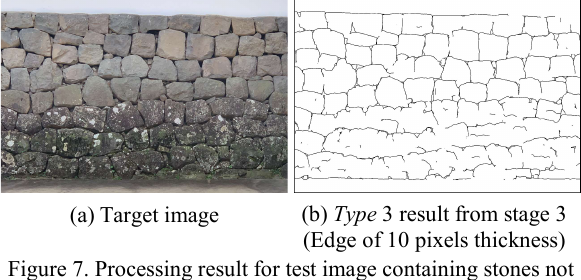
Figure 7. Processing result for test image containing stones not similar to training data